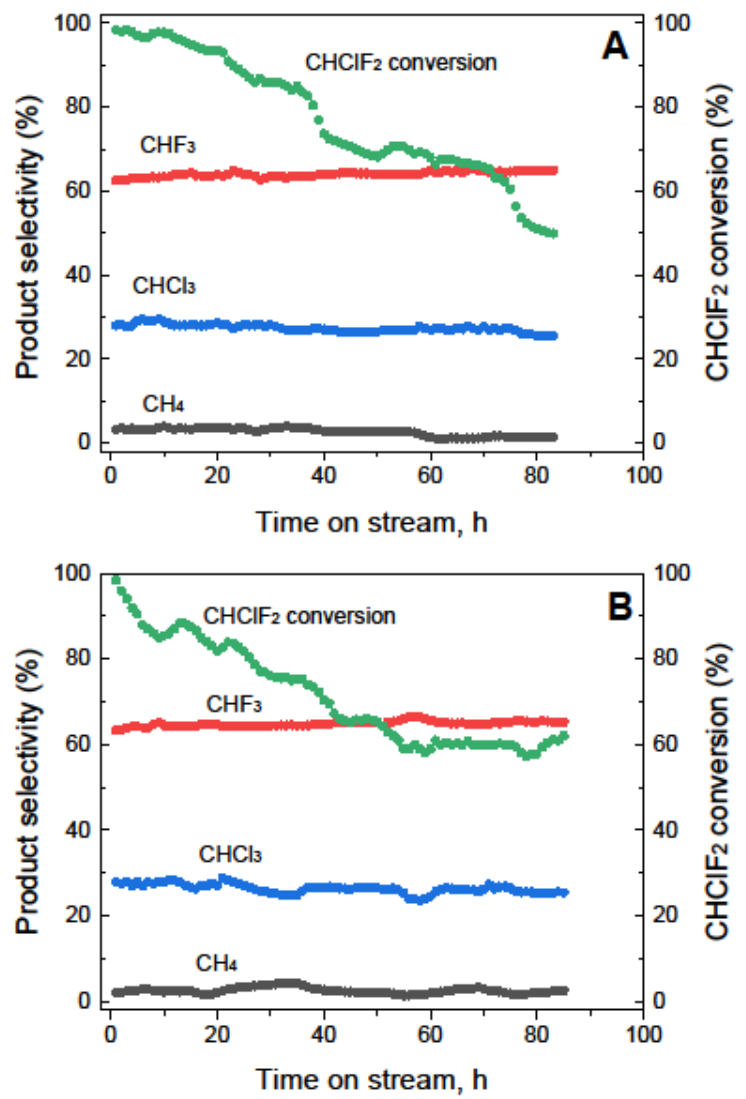
Figure 4. Overall conversion and product selectivity in the hydrodechlorination of freon R-22 over Pt/Al 2 O 3 catalysts: ( A )—sample prereduced in H 2 at 400 °C, ( B )—sample prereduced in H 2 at 500 °C. Time-on-stream behavior. Reaction temperature 180 °C. Operating conditions as in Figure 1.